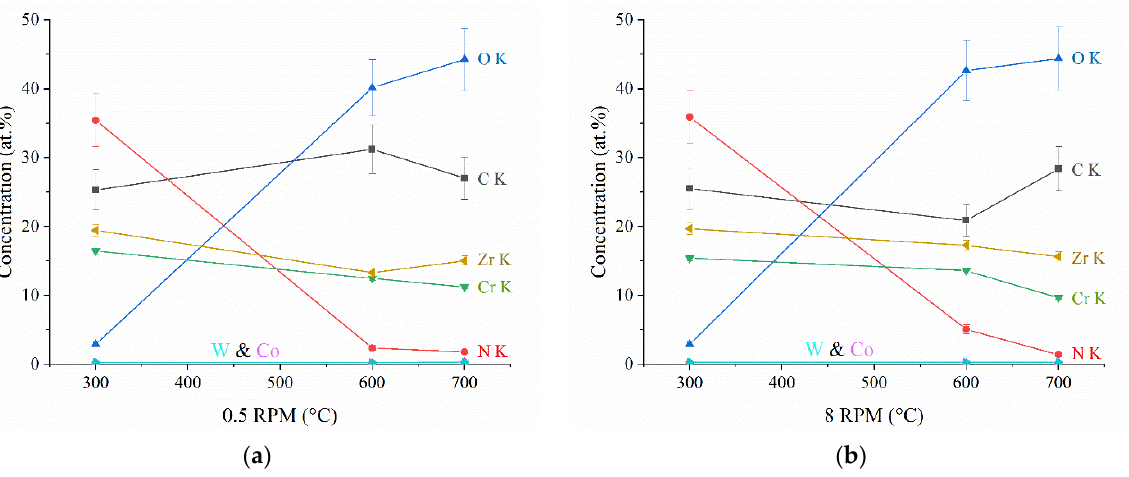
Figure 7. EDS element concentrations on 0.5 RPM ( a ) and 8 RPM ( b ) multilayer coatings oxidized at 300, 600 and 700 °C. 300, 600 and 700 ◦